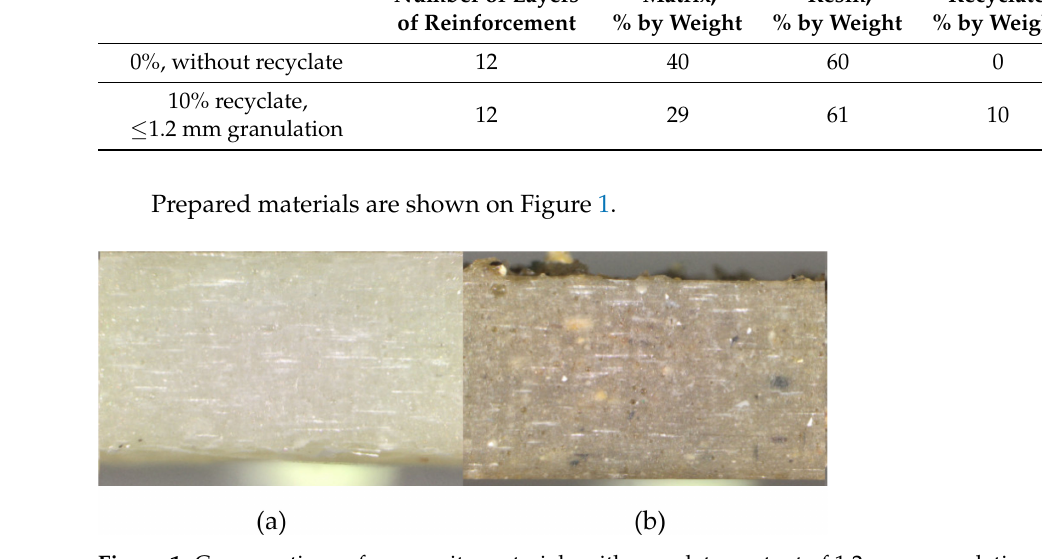
Figure 1. Cross-sections of composite materials with recyclate content of 1.2 mm granulation and percentage content: ( a ) 0%, ( b ) 10%, magnification × 3 (confocal